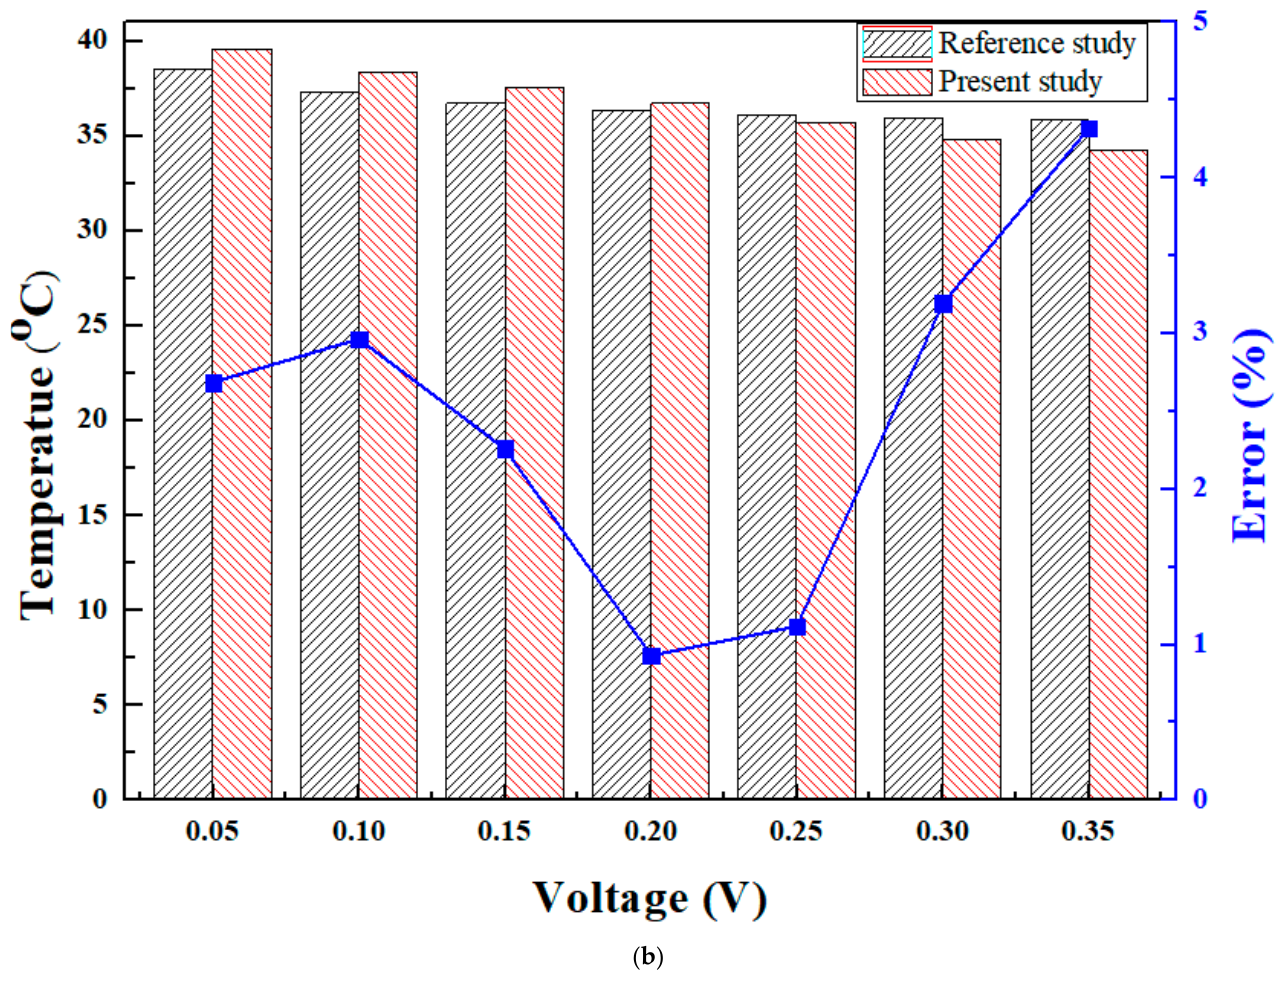
Figure 5. Comparison of simulated data from the present study with reference studies [43–45] for ( a ) velocity and ( b ) temperature.